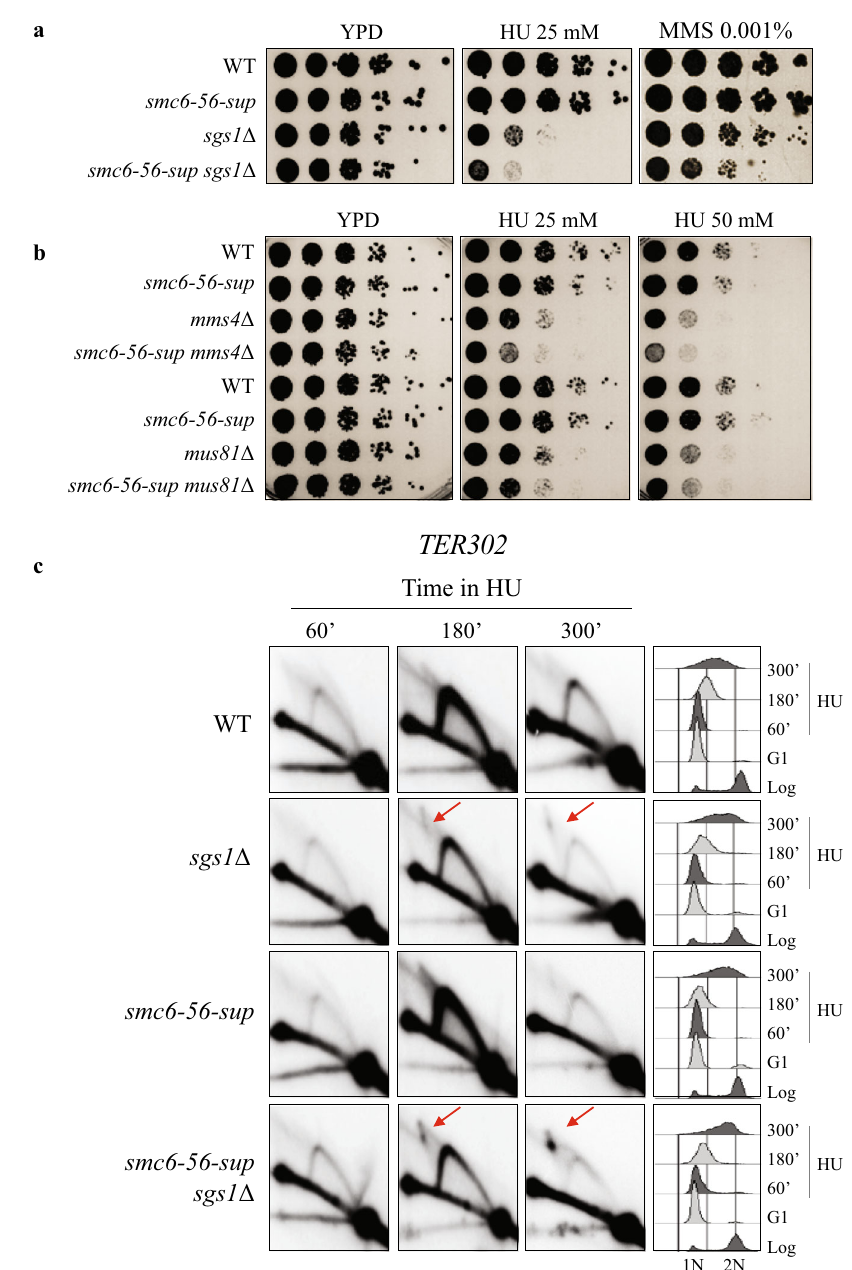
Fig. 5 Smc6-56-sup protein is defective in pathways complementary with Sgs1 and Mus81. a , b Additivity between smc6-56-sup and sgs1 Δ , mus81 Δ , mms4 Δ in regard to HU sensitivity. The experiments were repeated independently twice with similar results. c Visualization of replication intermediates at TER302 by 2D gel electrophoresis from cells of the indicated genotype synchronously released from G1 in media containing 200 mM HU. The experiment was repeated independently twice with similar results. Flow cytometry pro fi les are indicated on the right. Joint molecules accumulating on the X-arc are indicated by red arrows. See also Supplementary Fig. 6. Source data are provided as a Source Data fi